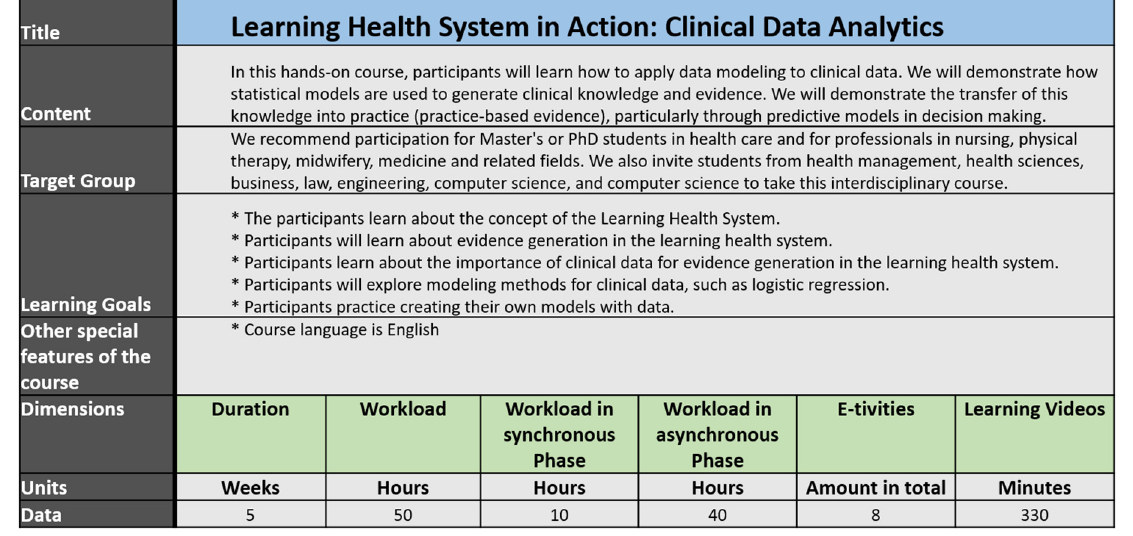
Figure 6. Course properties for ZLG-TP3-Demonstrator 2: “Learning Health System in Action: Clin- ical Data Analytics”.